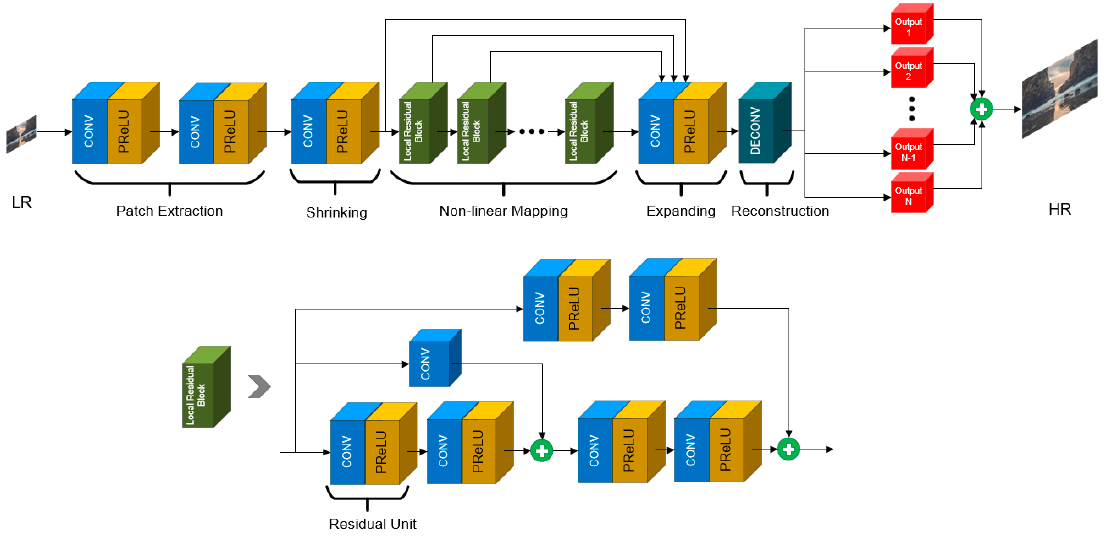
Figure 13. FGLRL network structure.